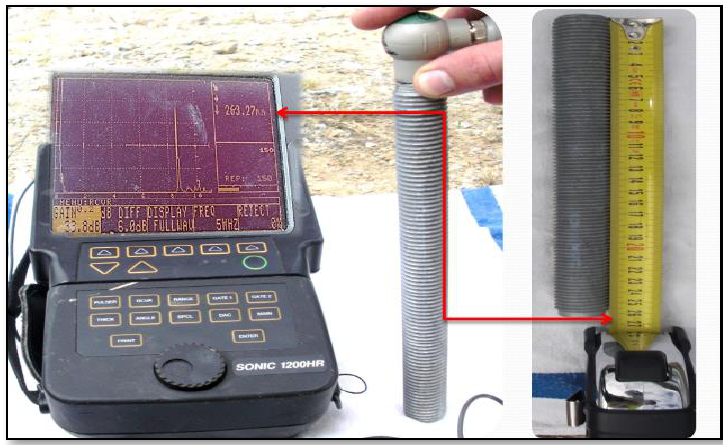
Figure 1. Setting and calibrating the US of the instrument .